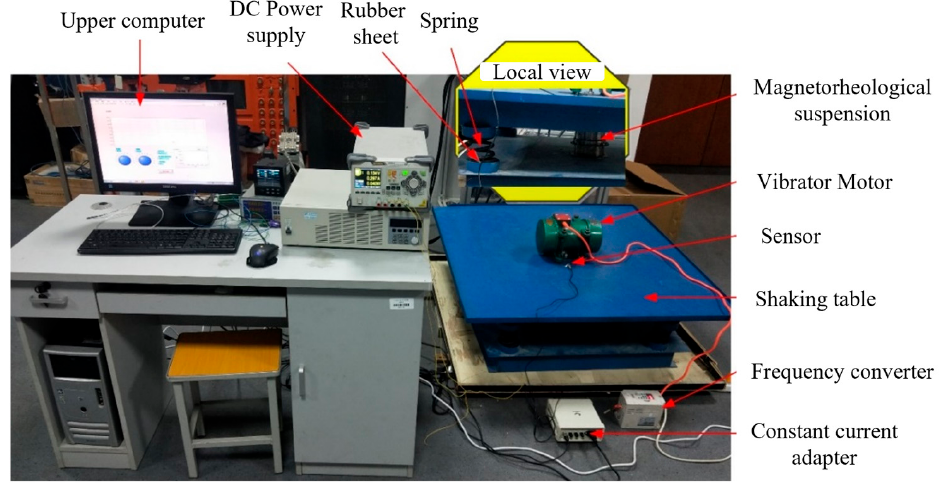
Figure 17. Test bench of magnetorheological suspension system.